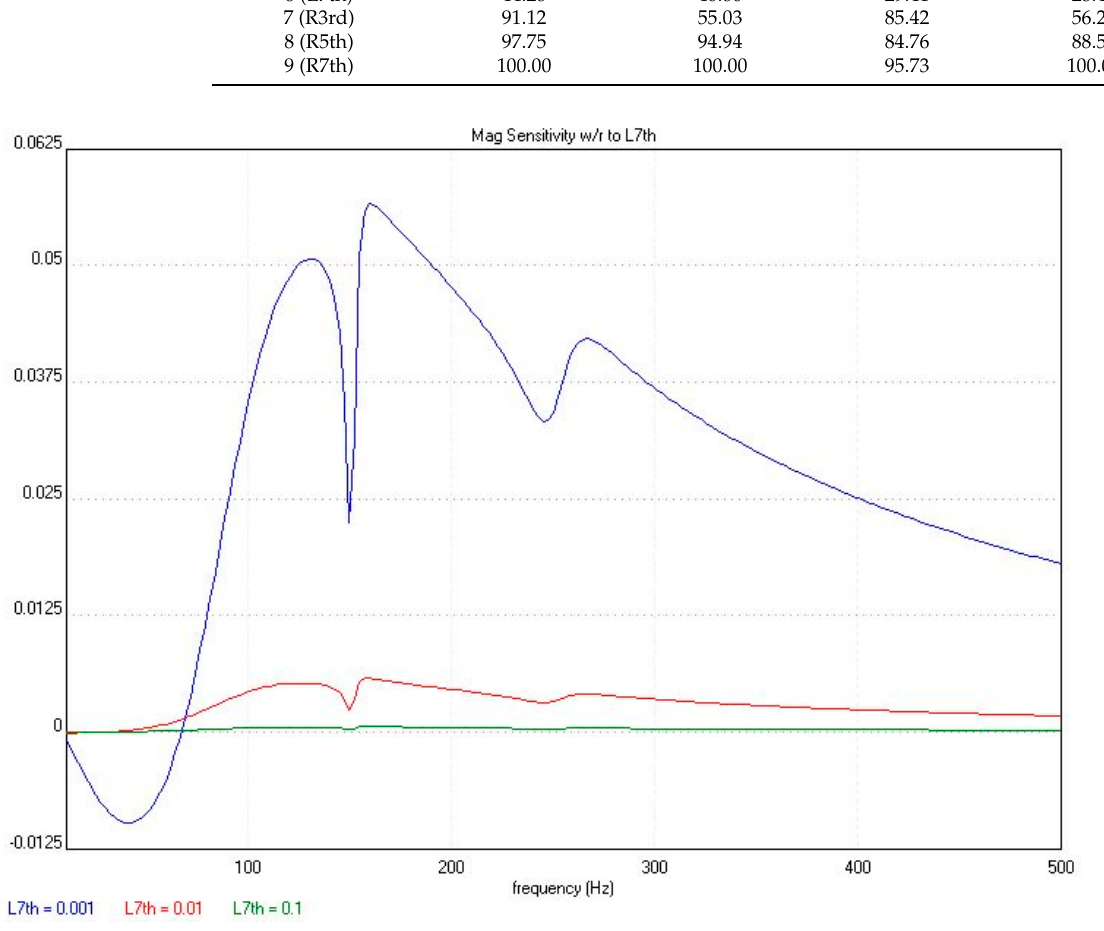
Figure 5. Magnitude response sensitivity of L 7 th. Table 6. Fault classification results in a network filter with evaluation of the response.